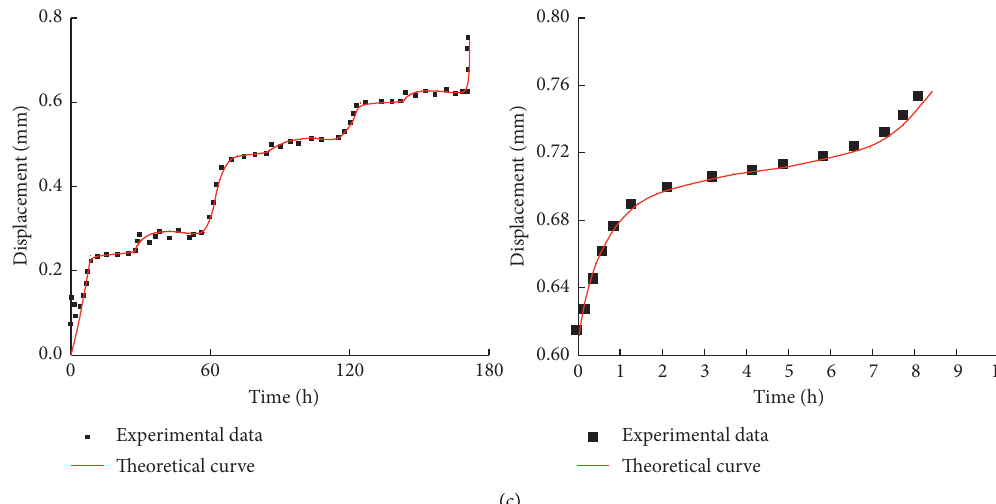
Figure 12: Comparisons between the experimental data and theoretical curves. (a) Anchored sandstone rock masses. (b) Anchored marble rock masses. (c) Anchored granite rock